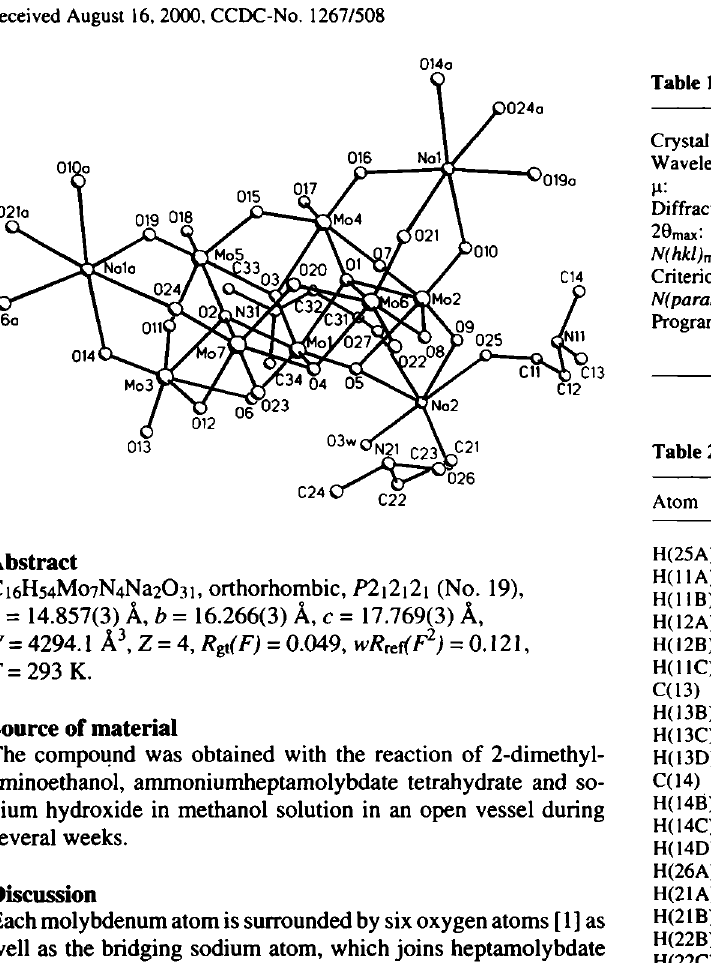
Table 1. Data collection and handling.